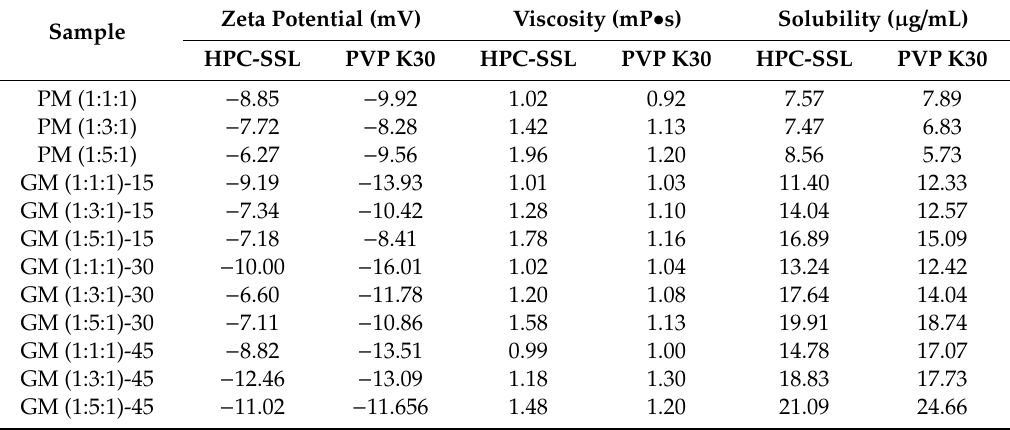
Table 4. Zeta potential, viscosity, and solubility in water of